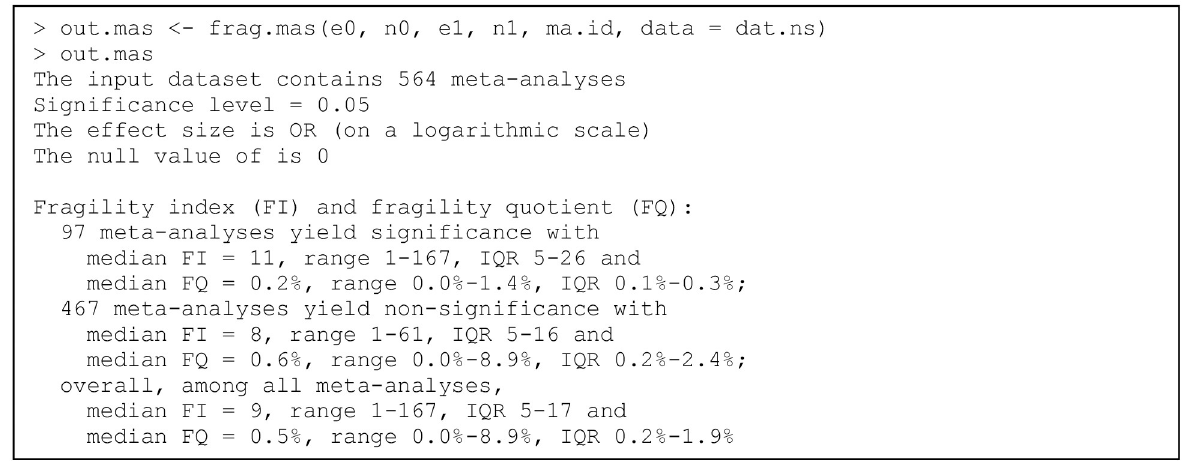
Fig 11. Output from the function frag.mas()